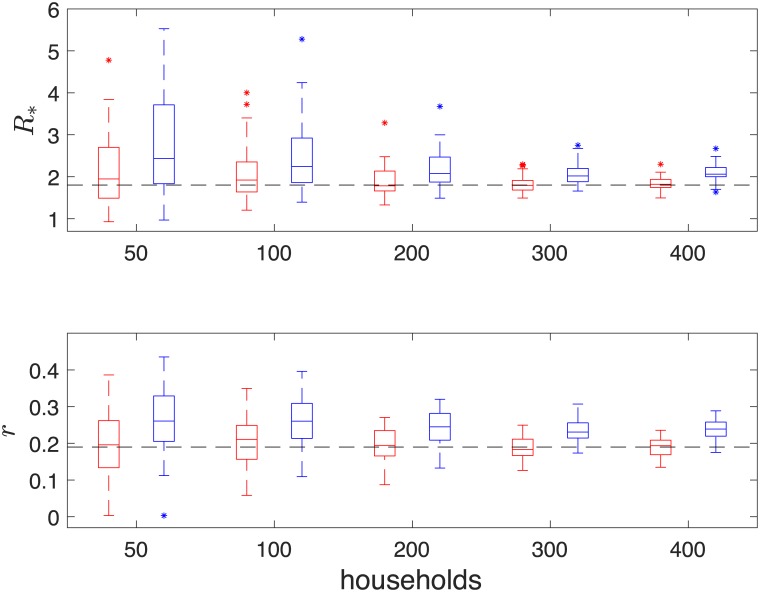
Boxplots of maximum a posteriori (MAP) estimates of (R*, r) from 50 simulations.Red and Blue boxes correspond to results from 2.5 × 106 iterations (thinned to 2.5 × 105) of the DA-MCMC algorithm and 105 iterations of the BPA and respectively. MAP’s are calculated from 2 dimensional kernel density estimates. The pairs of boxes from left to right are MAP’s from inference based upon data with 50, 100, 200, 300 and 400 infected households. Black dotted lines indicate the true parameter values at (R*, r) ≈ (1.803, 0.190).